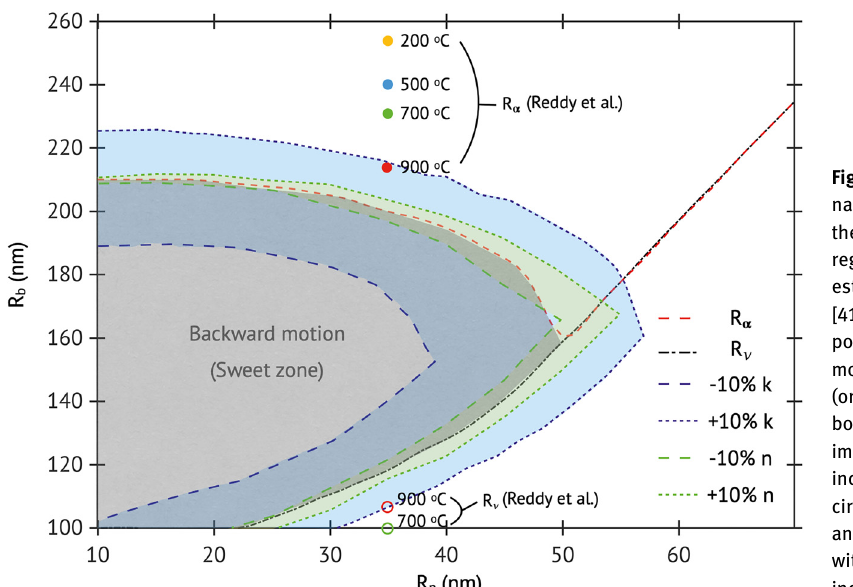
Figure 4: The minimum radius of nanobubble where the nodal point ( R ν ) or the asymptotic plane ( R α ) is observed. The region highlighted in gray, which is estimated with the refractive index from [41], indicates the conditions that can potentially initiate the backward ballistic motionof TiN NPs.The blueand greendash (or dot) lines, respectively, indicate the boundary of the sweet zone when the imaginary and the real part of refractive index increase (or decreases) by 10%. The circles indicate the calculated ( R α ) ( fi lled) and R ν (opened) of a 35-nm-radius TiN NP with the temperature-dependent refractive index from Reddy et al.